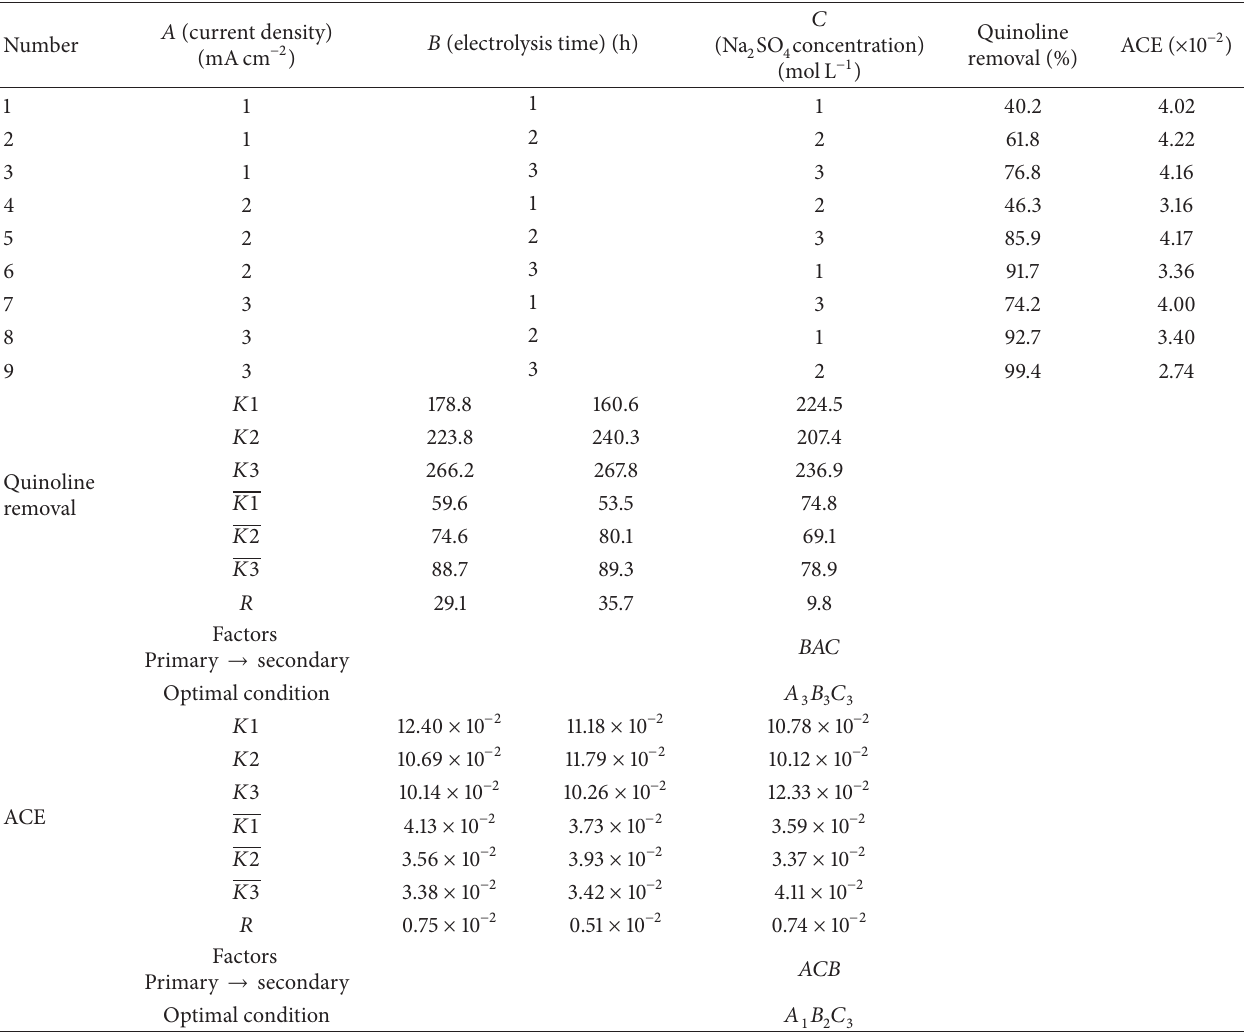
Table 2: L 9 ( 3 ) 3 orthogonal test results.